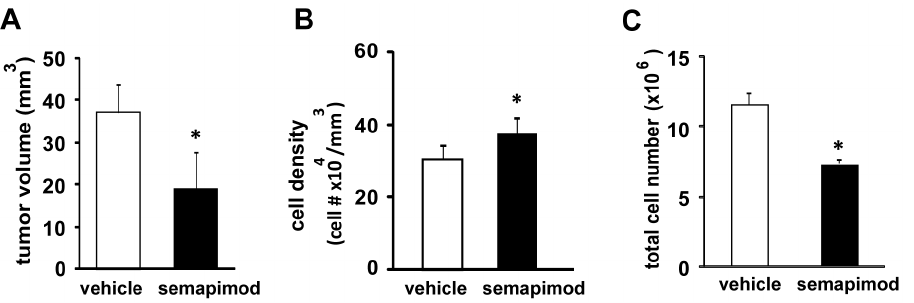
Figure 5. Semapimod inhibits tumor growth in vivo . GL261 cells were implanted and mice were treated as described in Fig. 4. (A) Quantification of tumor volume. Data shown represent the average + / 2 SEM of 5 different tumors. (B) Quantification of tumor cell density. Data shown represent the average + / 2 SEM of 5 different tumors. (C) Quantification of total tumor cell number. Data shown represent the average + / 2 SEM of 5 different tumors. *: p , 0.05 student’s 2 tailed t-test.